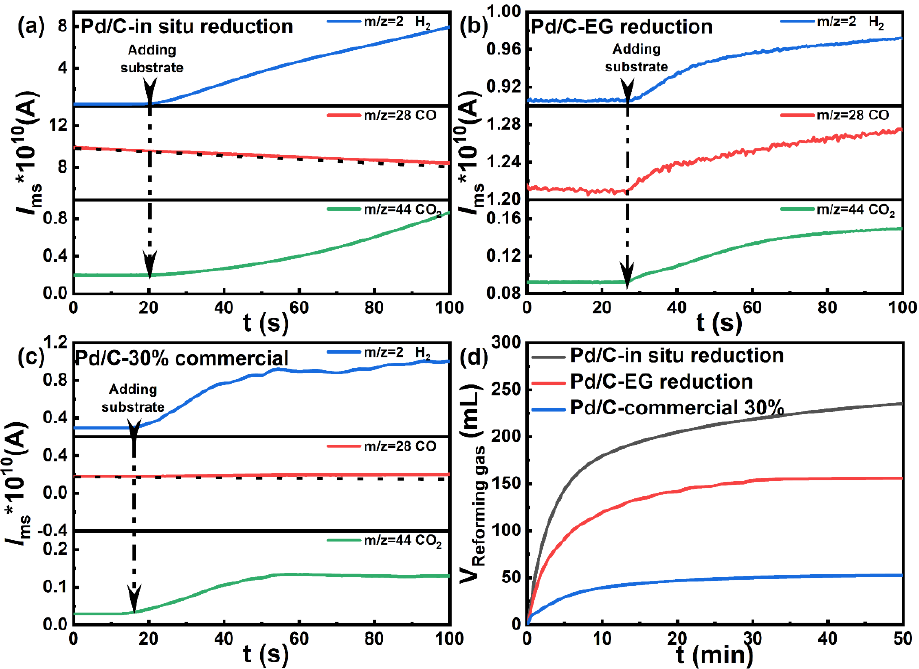
Figure 4. In situ mass spectra of the products during formic acid decomposition over ( a ) Pd/C in situ reduction, ( b ) Pd/C-EG reduction and ( c ) Pd/C-30% commercial; ( d ) Comparison of these three catalysts’ performance under 343